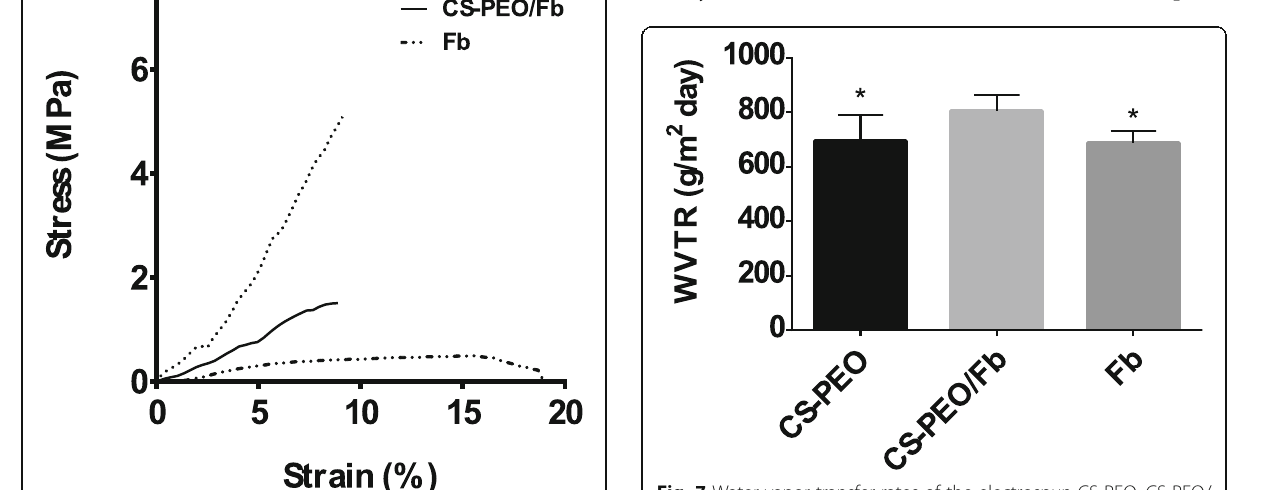
Fig. 7 Water vapor transfer rates of the electrospun CS-PEO, CS-PEO/ Fb, and Fb scaffolds. Error bars represent standard deviation ( n = 6, * p < 0.05 when compared to CS-PEO/Fb